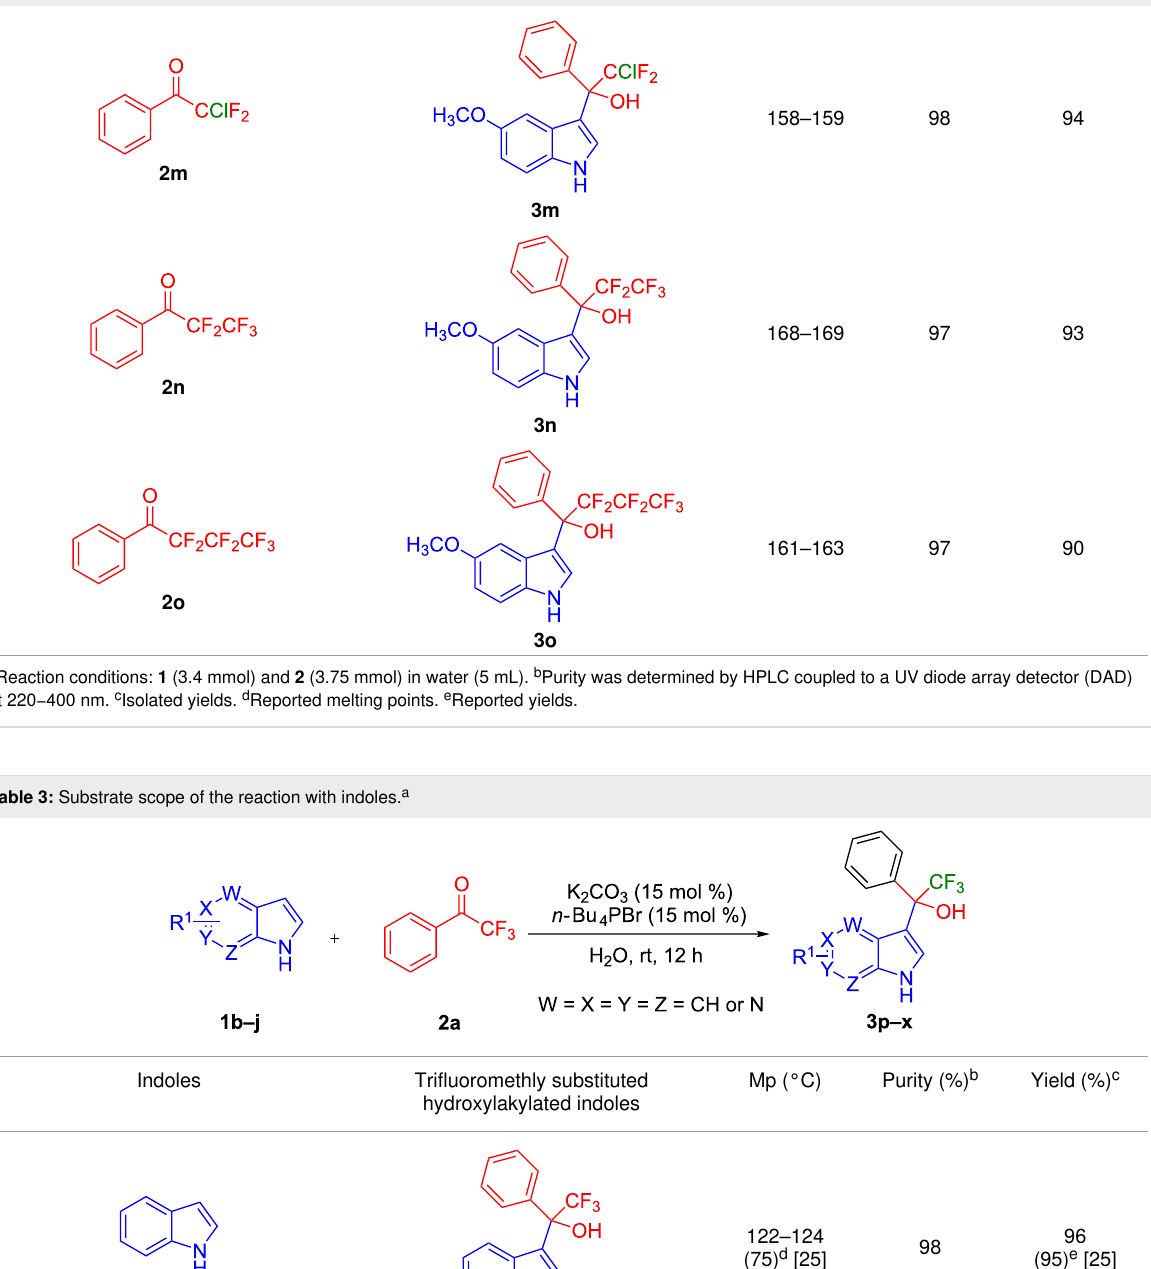
Table 2: Substrate scope of the reaction with ketones. a (continued)